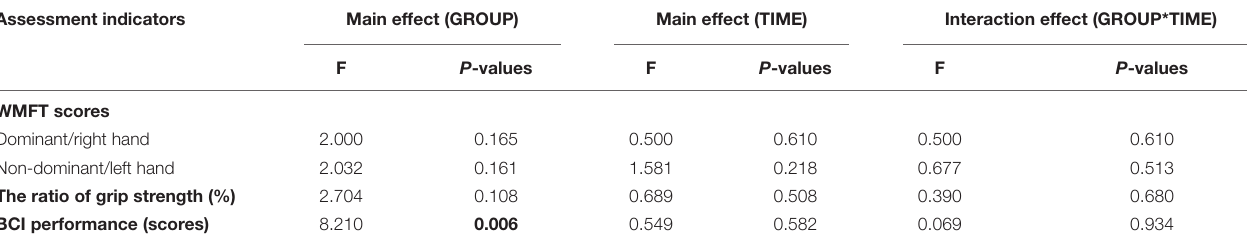
TABLE 1 | Results of analysis of variance (ANOVA) conducted on GROUP, TIME, and interaction effect on wolf motor function test (WMFT) and brain computer interface (BCI) performance. Assessment indicators